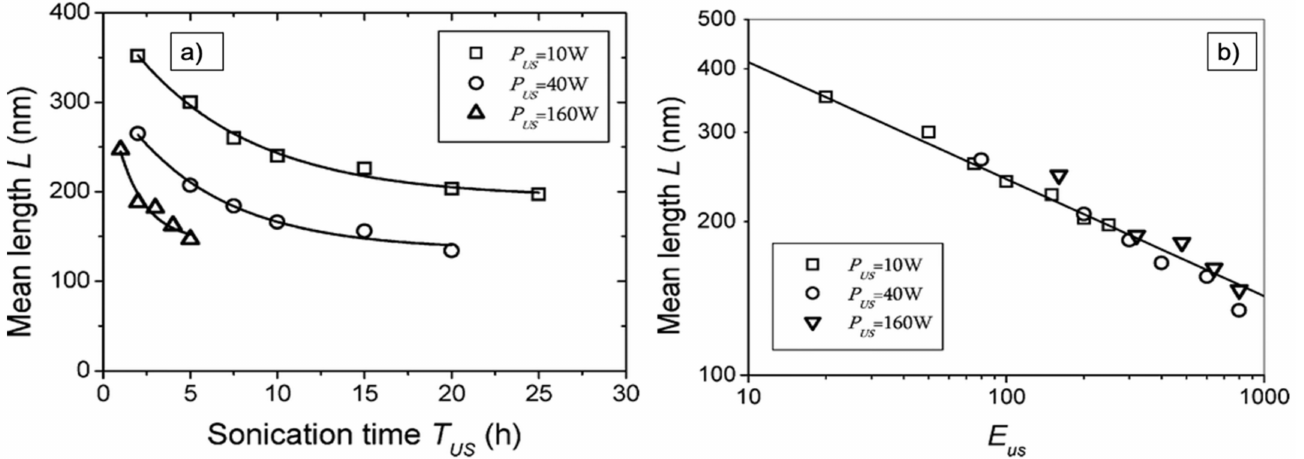
Figure 4. Display of the power law behavior of the mean length of MWCNT shortened by sonication. ( a ) Length as a function of the sonication time; ( b ) length as a function of the sonication energy, exhibiting L~E-0.21 for all applied sonication powers. Reprinted with permission from [37], Copyright (2009) American Chemical